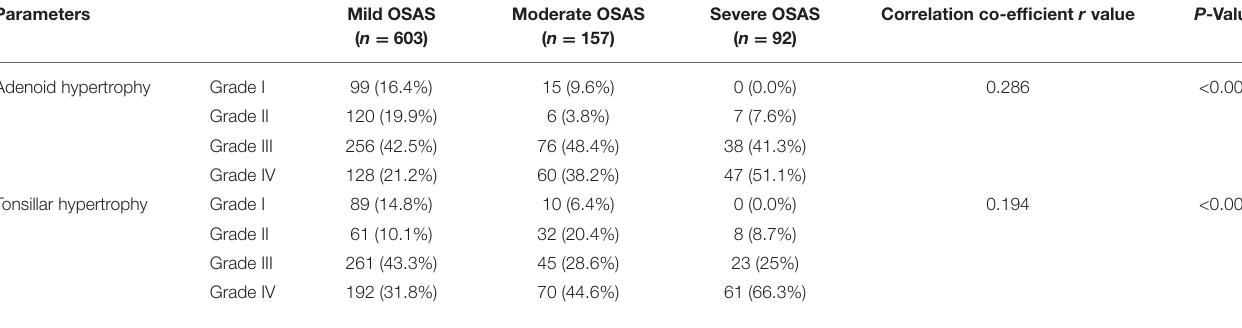
TABLE 5 | Spearman correlation analyses of the relationships between adenotonsillar hypertrophy and the severity of pediatric OSAS. Parameters Mild OSAS ( n =